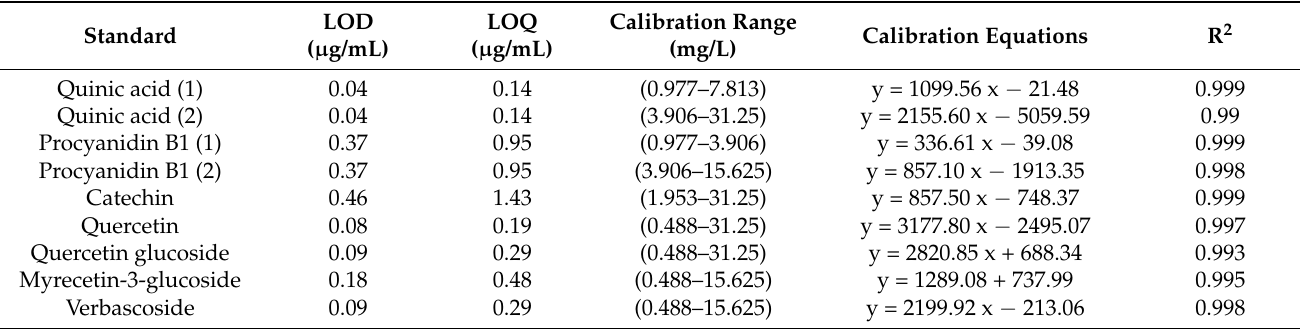
Table 1. Quantification data of identified phenolic compounds from avocado seed and